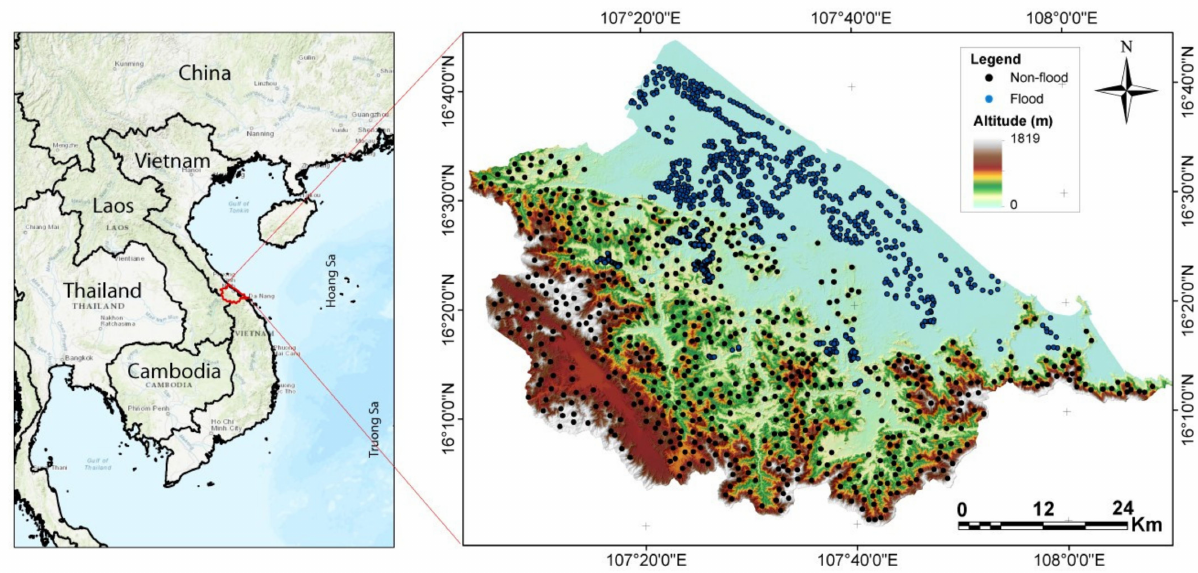
Figure 1. Study area